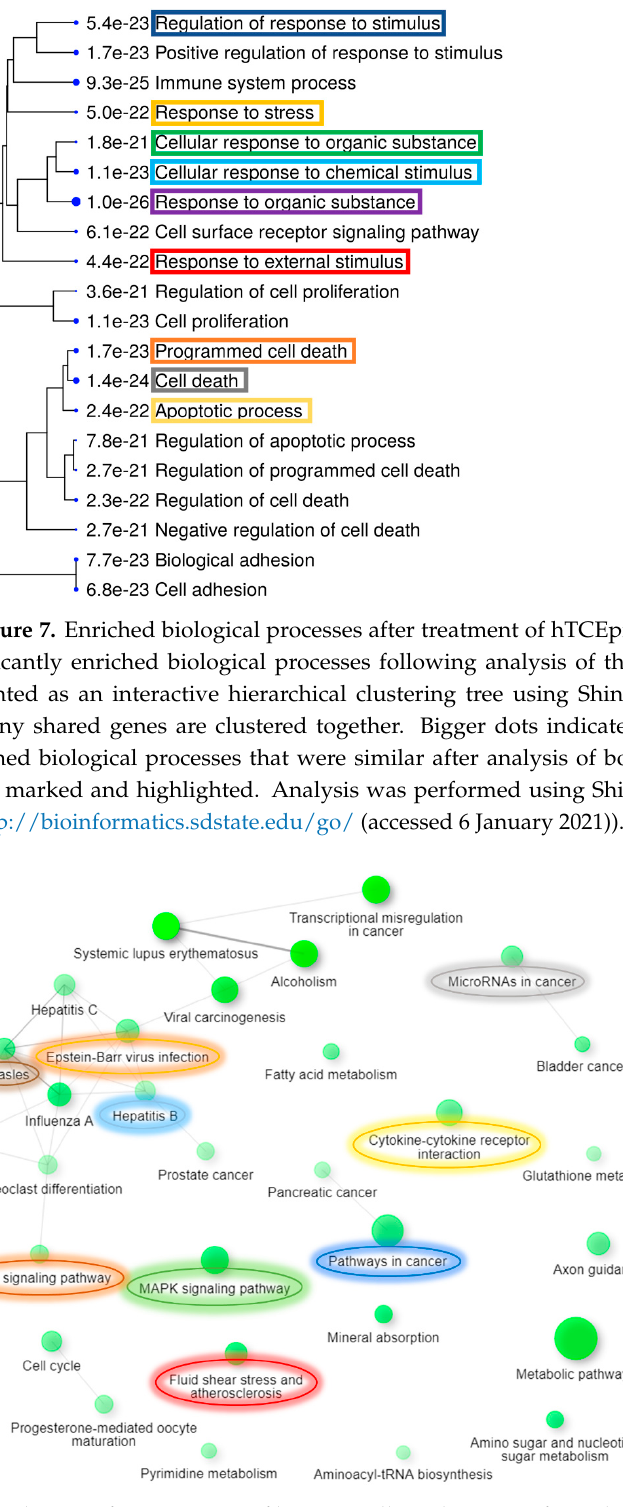
Figure 8. Enriched molecular pathways after treatment of hTCEpi cells with AC EFs for 24 h. The relationships between pathways are depicted and highlighted as an interactive graphical network using ShinyGO. Pathways enriched following analysis of the gene array data are shown. Two pathways (nodes) are connected after sharing 20% or more genes. Enriched pathways that were similar after analysis of both gene and protein array data are marked and highlighted. Node colors illustrate enrichment, whereby darker nodes represent significantly enriched gene sets, while bigger nodes represent larger gene sets. Thicker edges represent more overlapped genes. Analysis was performed using ShinyGO (v.0.61) (Available online: http://bioinformatics.sdstate.edu/go/ (accessed on 6 January 2021)). Edge cut-off = 0.2 and FDR p -value cut-off = 0.05.